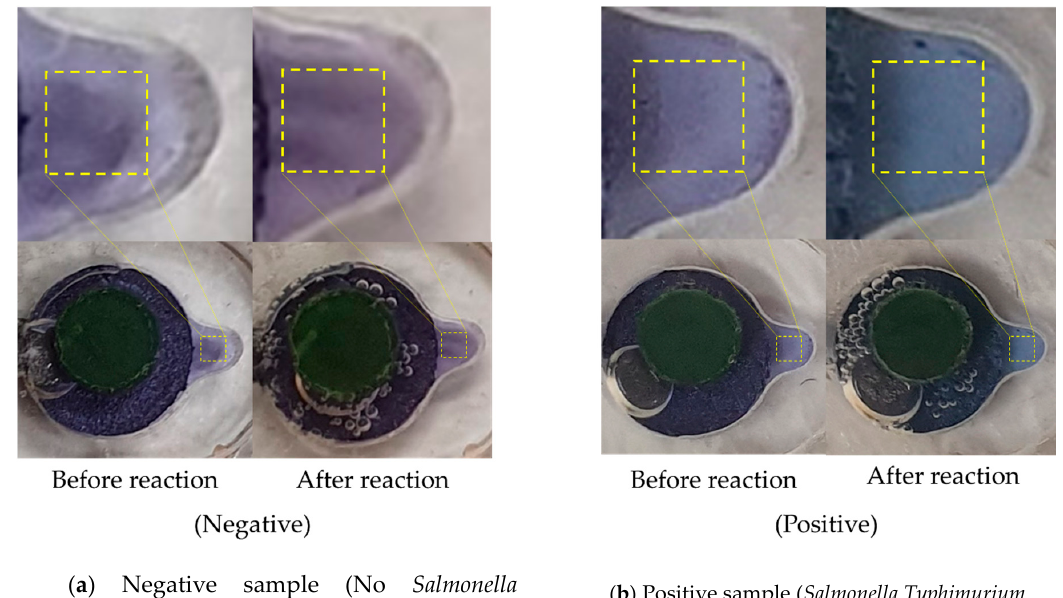
Figure 7. Colorimetric analysis of LAMP product using hydroxy naphthol blue (HNB), where the dotted boxes (30 × 30 pixels) indicate the region of interest (ROI) on the colorimetric detection chamber.